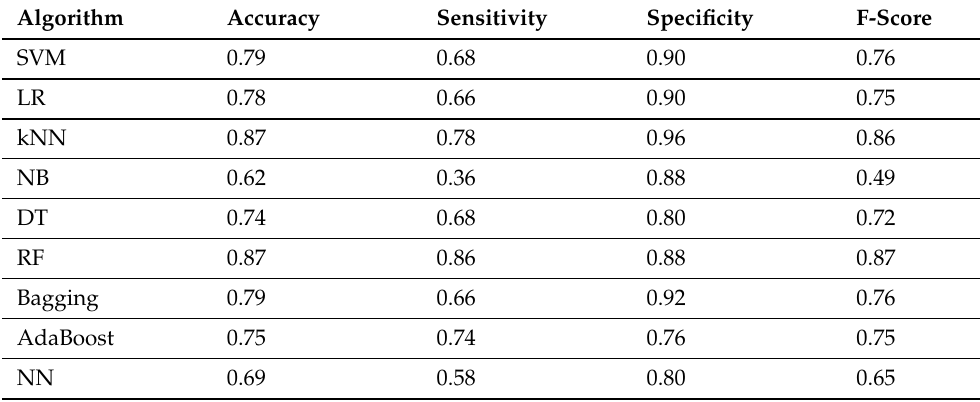
Figure 5. Results using 6 features whose correlation > 0.25. Table 5. Results using first 17 features ranked using